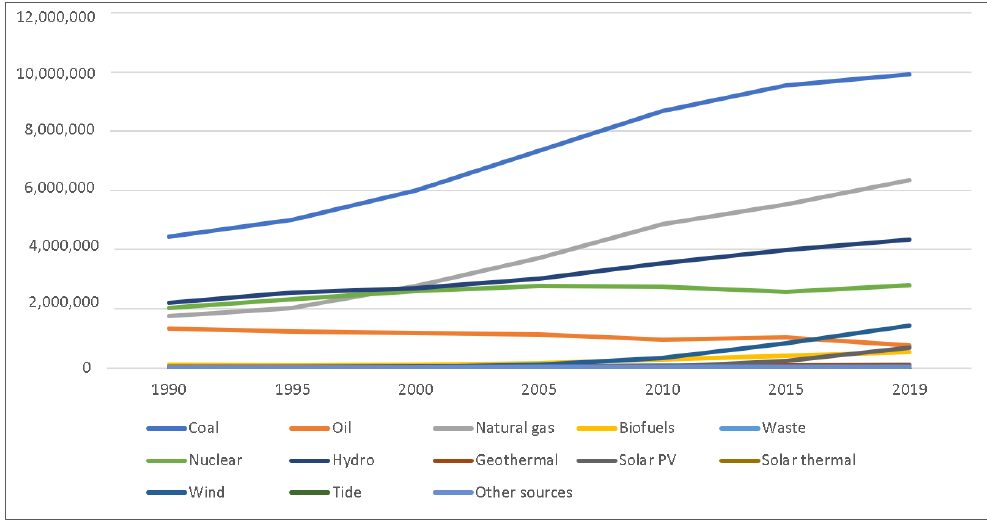
Figure 7. Global electricity generation by source (GWh) and year (1990 – 2019), derived from [19].